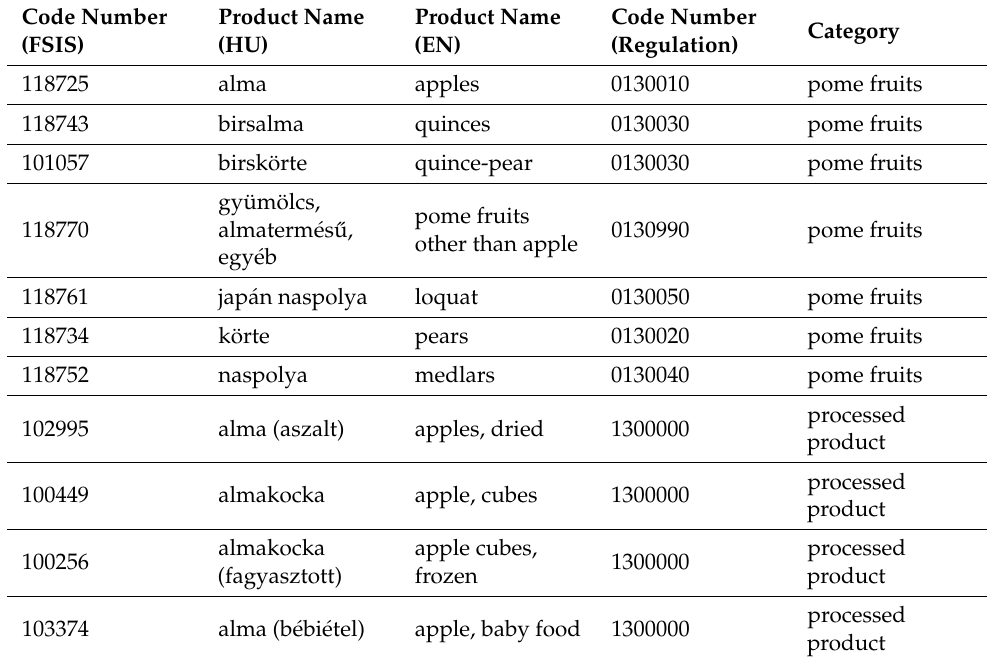
Table A3. Products of plant and animal origin referred to in Article 2(1) to which MRLs apply 1